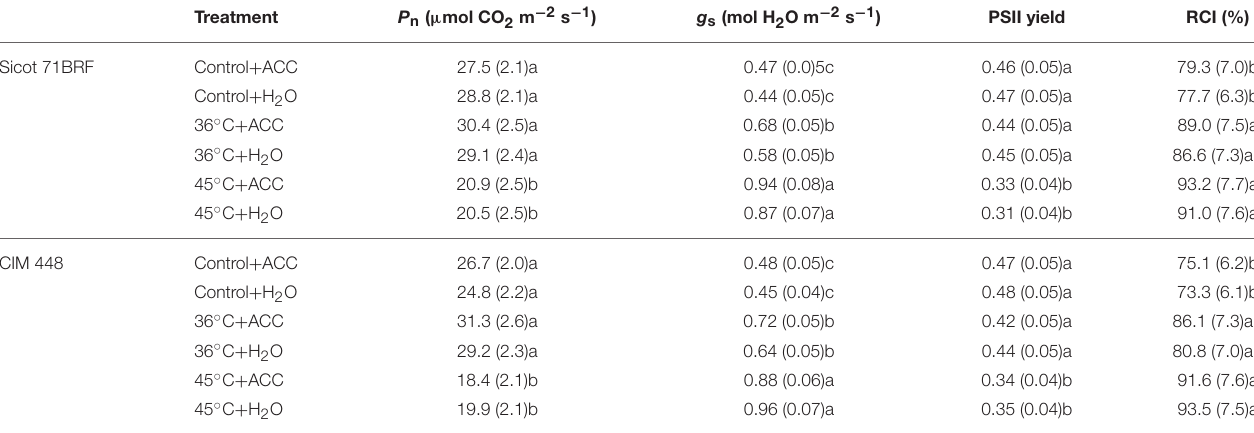
TABLE 2 | Changes in various physiological componets of different cotton genotypes in response to heat shock (36 and 45 ◦ C) and 1-aminocylopropane-1-carboxlyic acid (ACC) application in experiment 2.